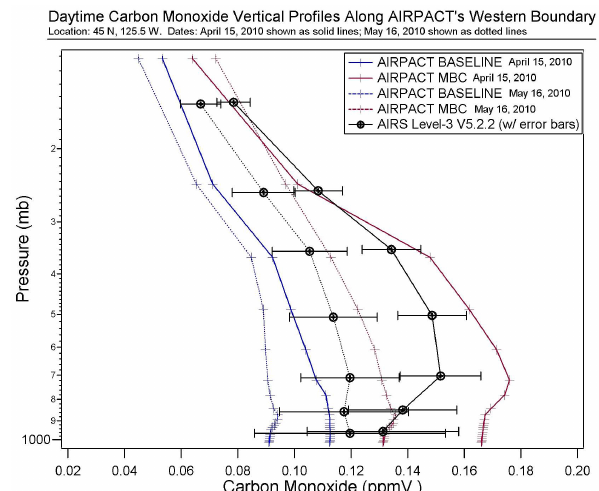
Fig. 4. Carbon monoxide vertical profiles midway along AIRPACT- 3’s western boundary for 15 April (solid lines) and May 16 (dotted lines) at ∼ 02:00 p.m